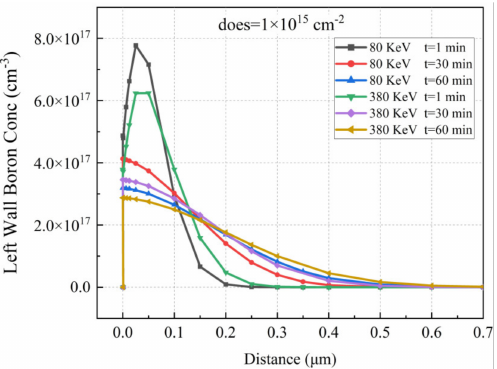
Figure 15. Comparison of doping curves with different implantation energy and diffusion